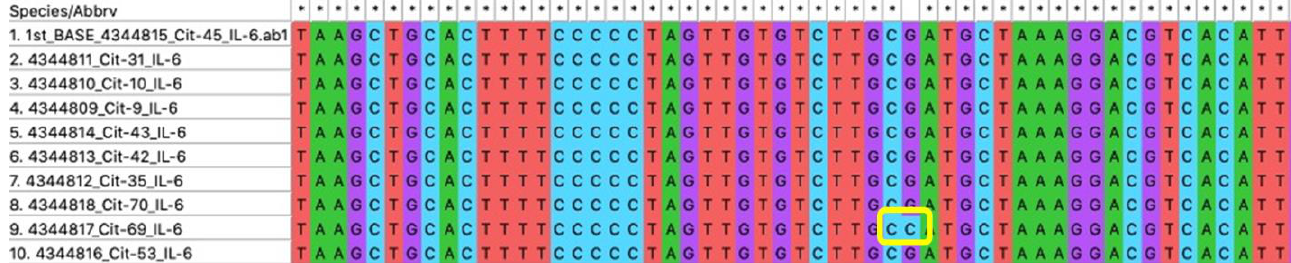
Figure 4. Identification and genotyping of SNP using direct sequencing method for confirmation: ( A ) chromatogram of GC genotype (heterozygote); ( B ) chromatogram of GG genotype (major ho- mozygote).